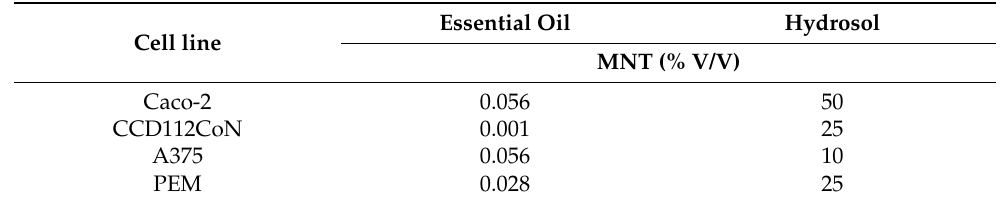
Table 1. Maximal nontoxic concentrations (MNTs) of H. italicum essential oil and hydrosol for different cell lines.